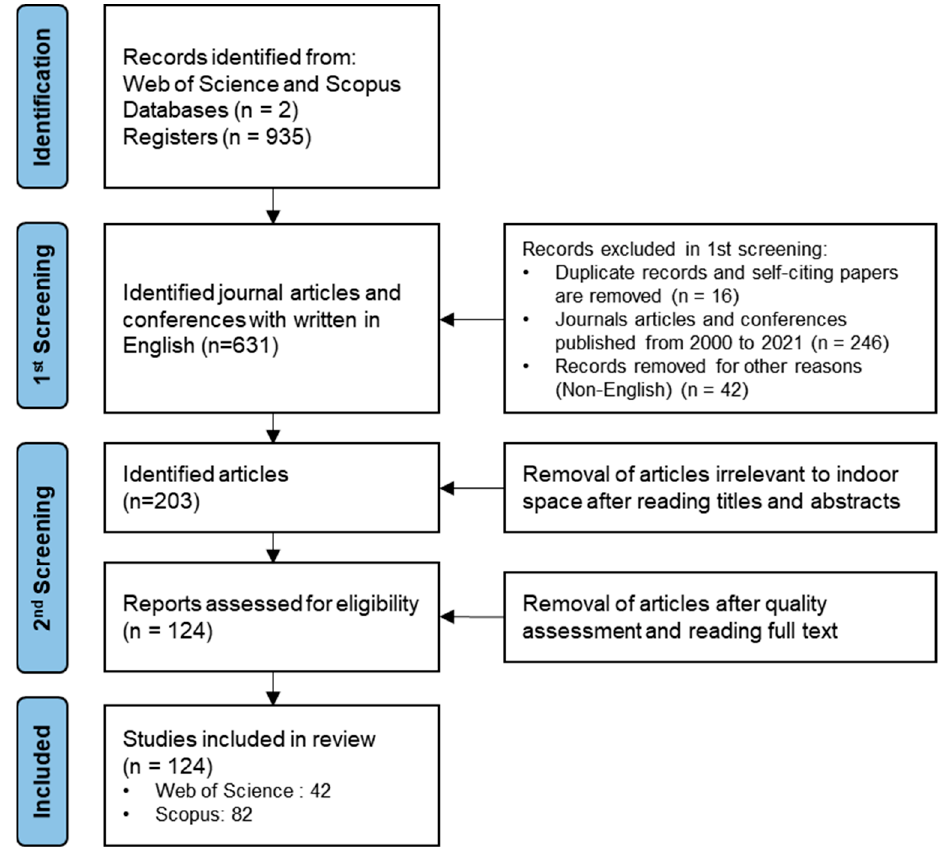
Figure 1. PRISMA flowchart for identifying